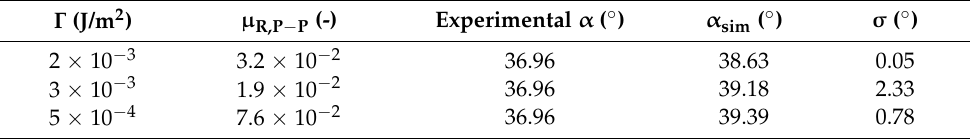
Table 4. Pairs of parameters ( Γ and µ R,P − P ) from the logarithmic curve for which the experimental α and that obtained from the simulation ( α sim ) are matched. σ is the standard deviation of α from the